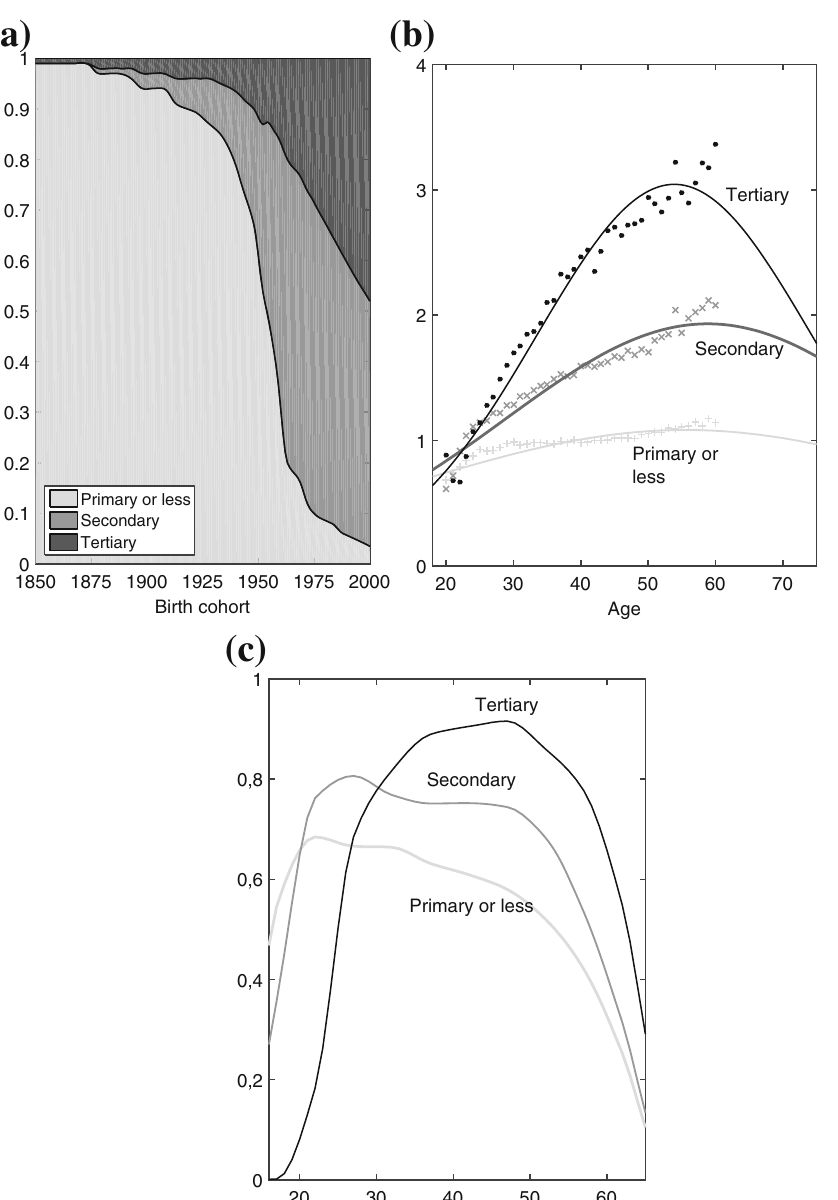
Fig.4 Decompositionofthestockofhumancapitalbyeducationalattainment(bothsexescombined). a The educational distribution, E c ( e ) , b the endowment of efficient labor units, WP and c labor force participation rates, LF. Sources Educational distribution data is taken from the Wittgenstein Centre Data Explorer (Wittgenstein Centre for Demography and Global Human Capital 2015), the endowment of efficient labor units comes from MTAS (2010), and the average labor force participation rate between 1987 and 2013 is calculated using data from INE